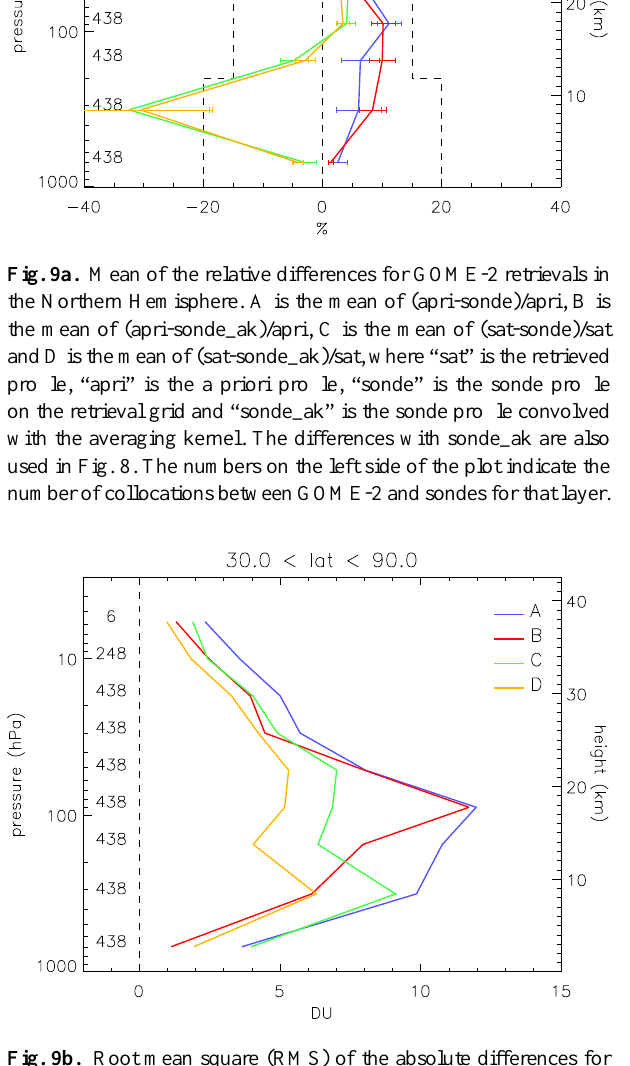
Fig. 9b. Root mean square (RMS) of the absolute differences for GOME-2 retrievals in the Northern Hemisphere. A is the RMS of apri-sonde, B is the RMS of apri-sonde_ak, C is the RMS of sat- sonde and D is the RMS of sat-sonde_ak, where “sat” is the re- trieved profile, “apri” is the a priori profile, “sonde” is the sonde profile on the retrieval grid and “sonde_ak” is the sonde profile con- volved with the averaging kernel. The numbers on the left side of the plot indicate the number of collocations between GOME-2 and sondes for that layer.